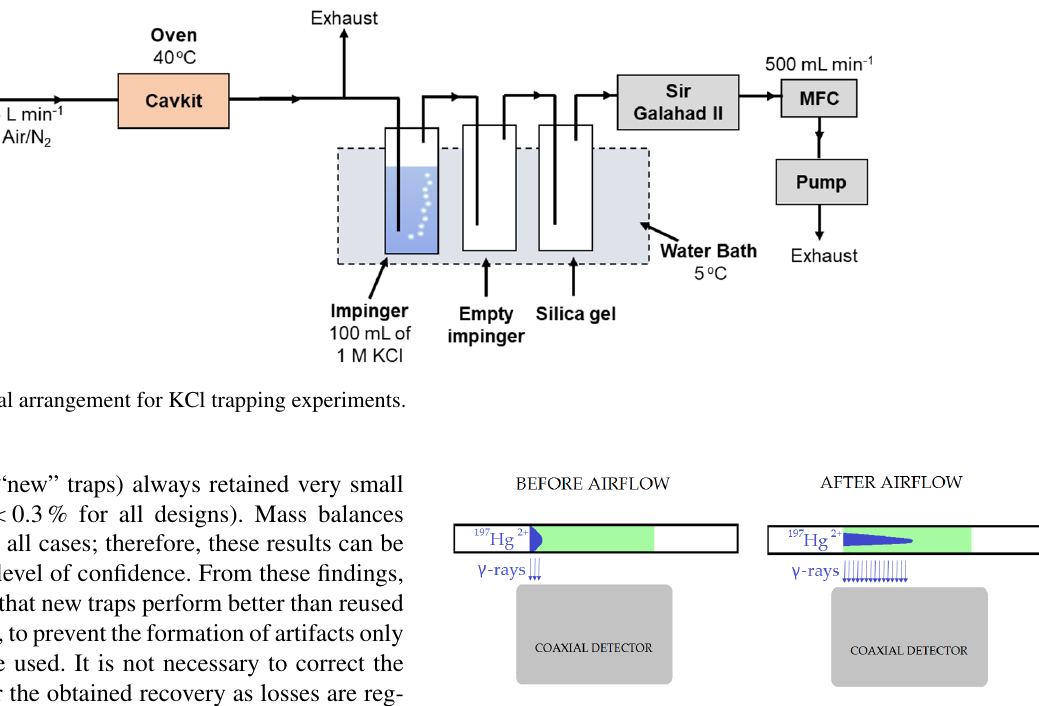
Figure 5. Effect of radiotracer distribution change along the trap on the activity measurement after exposure of KCl sorbent traps to airflow (not depicted to